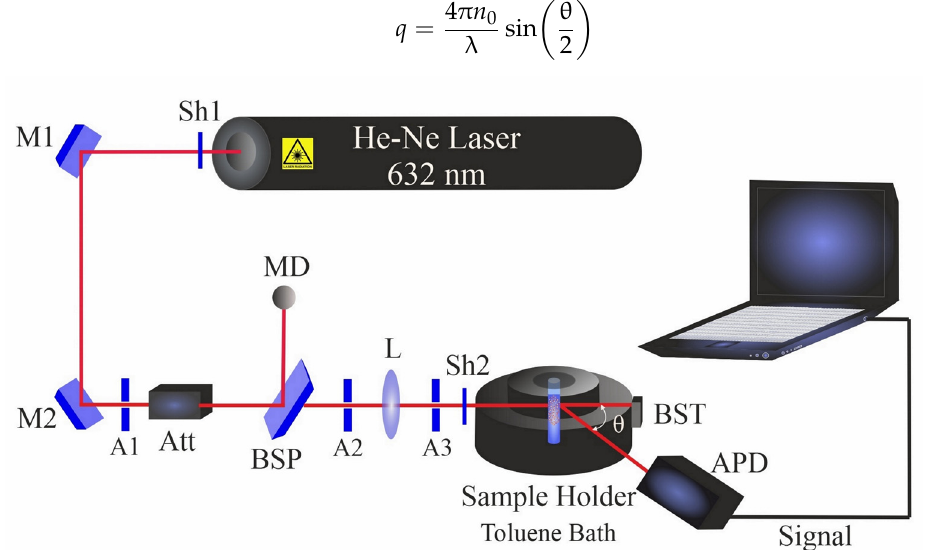
Figure 2. Dynamic light scattering setup. Shutters (Sh1 and Sh2); mirrors (M1 and M2); apertures (A1–A3); beam splitter plate (BSP); attenuator (Att); beam stopper (BST); bispherical lens (L); monitor diode (MD); and avalanche photodiode (APD).